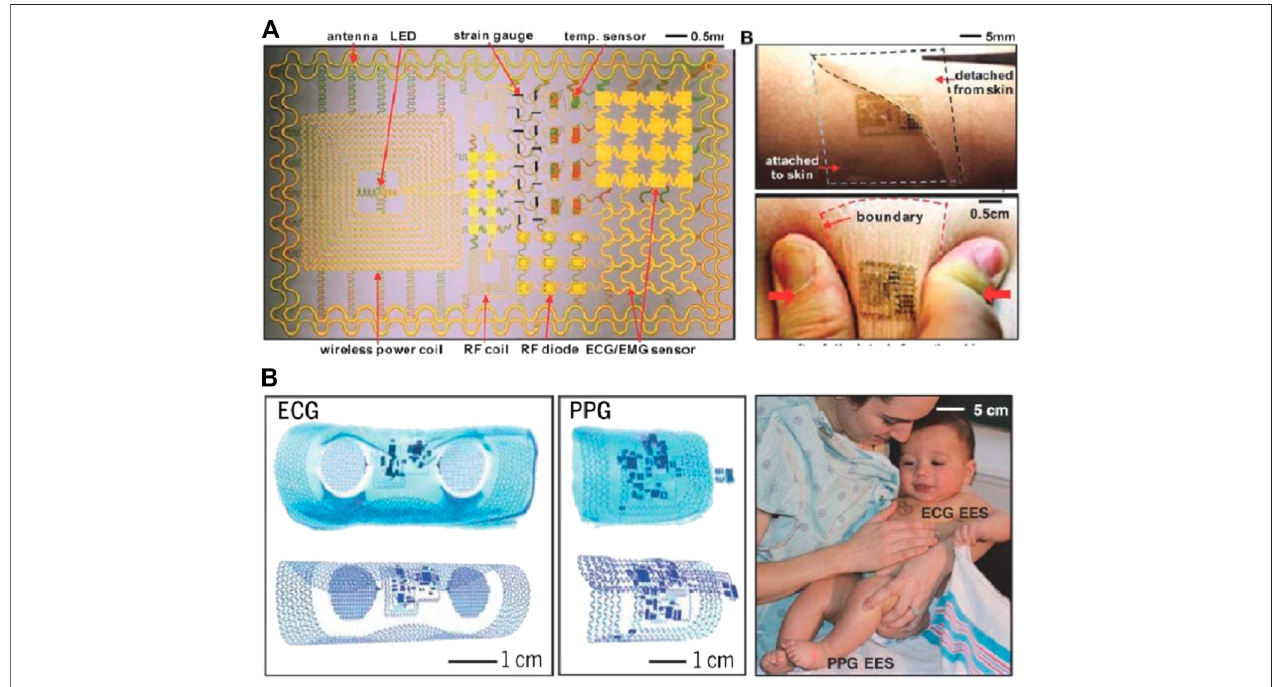
FIGURE 11 | (A) Multifunctional electronics with physical properties matched to the epidermis. (B) Wireless multifunctional epidermal electronic systems for neonatal intensive care (Chung et al., 2019). Reproduced with permission.